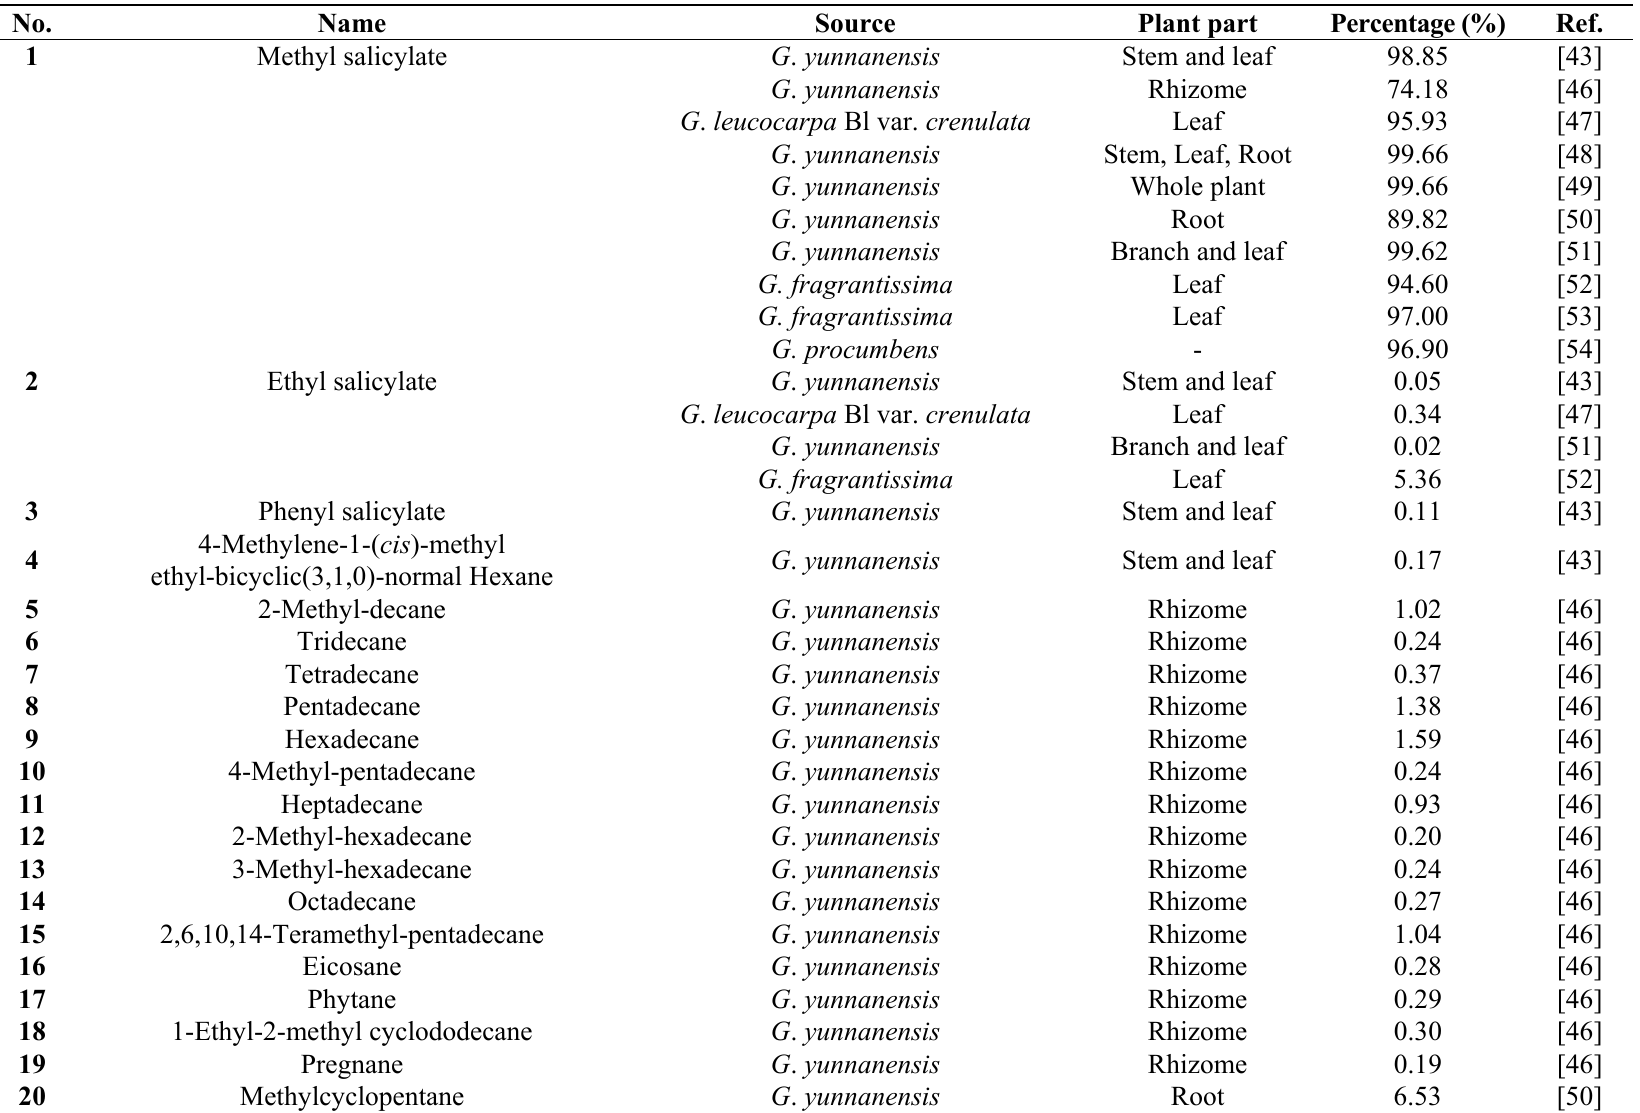
Table 2. Essential Oils of Genus Gaultheria